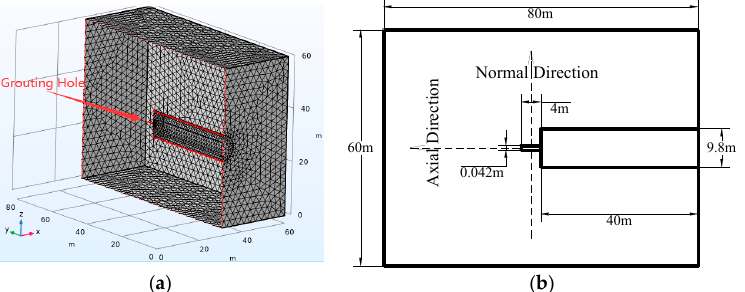
Figure 3. Illustrations of the numerical model. Panel ( a ) displays the 3D section view of the model; ( b ) displays the 2D abbreviated drawing of the model.